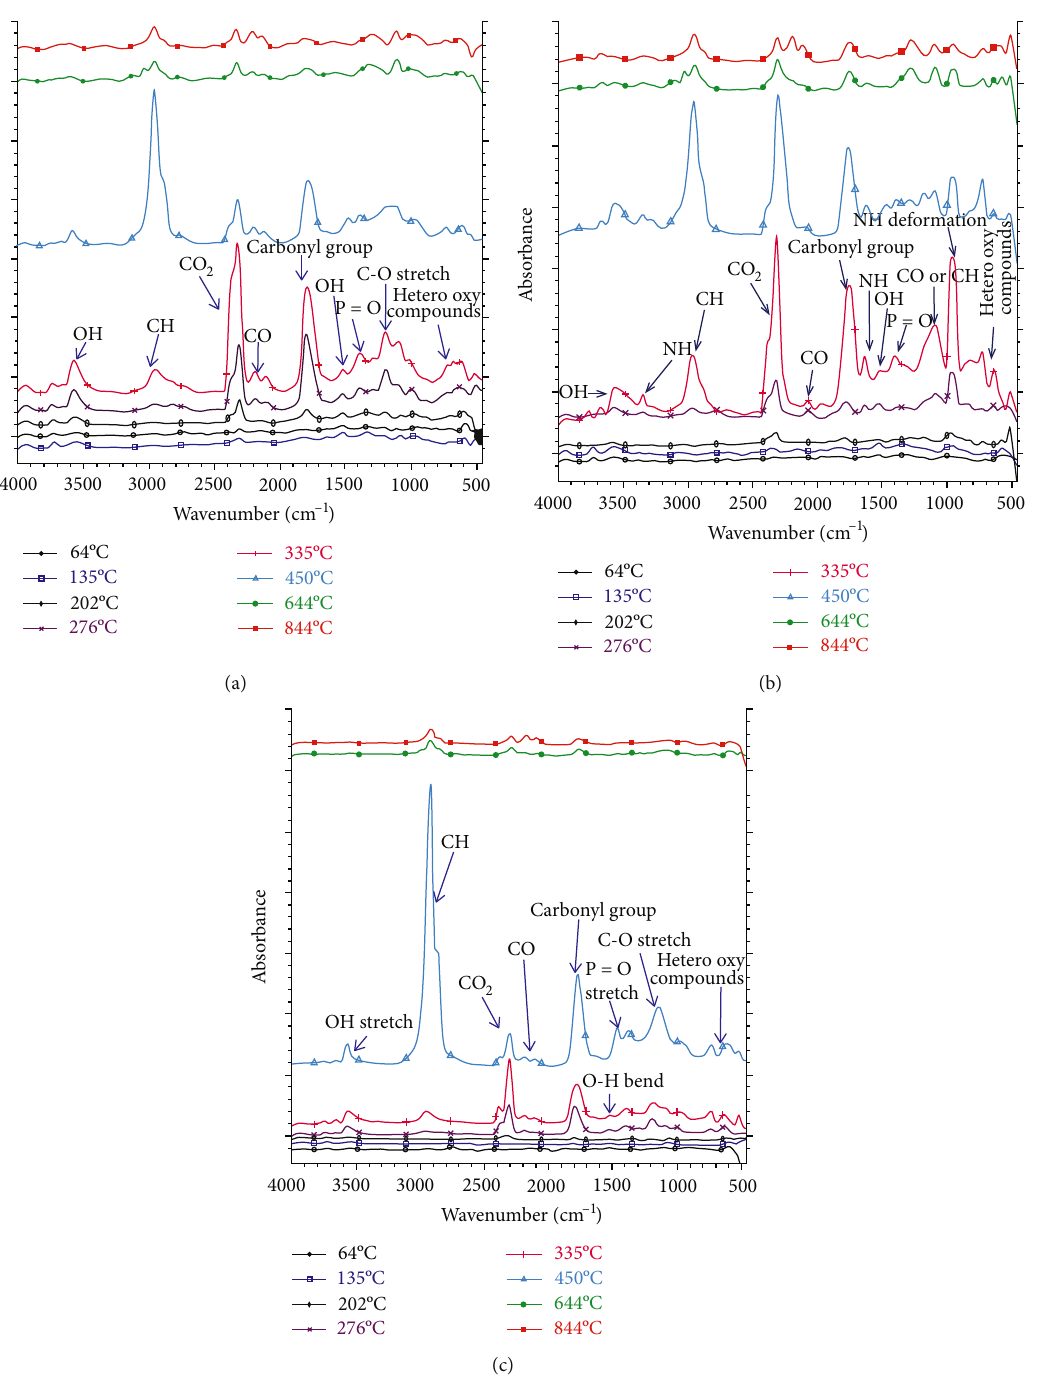
Figure 1: FTIR analysis of (a) sweet corn, (b) mopane worm, and (c) peanuts with an increase in temperature from 64 to 844 °